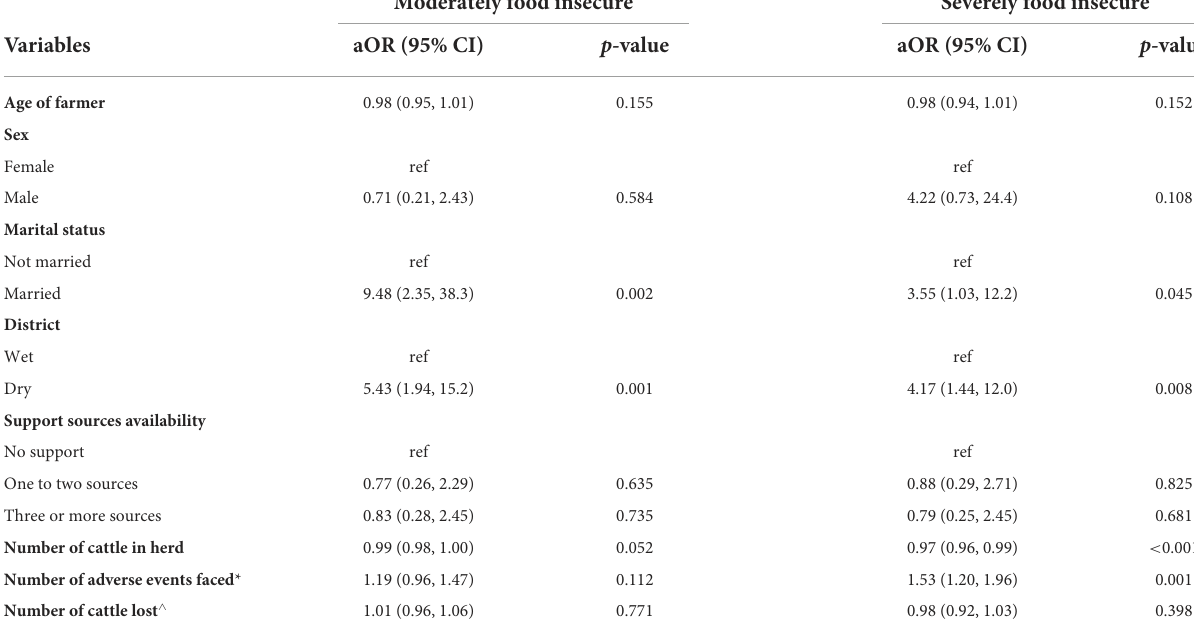
TABLE 5 Multivariable analysis of food security level predictors of cattle farming households in